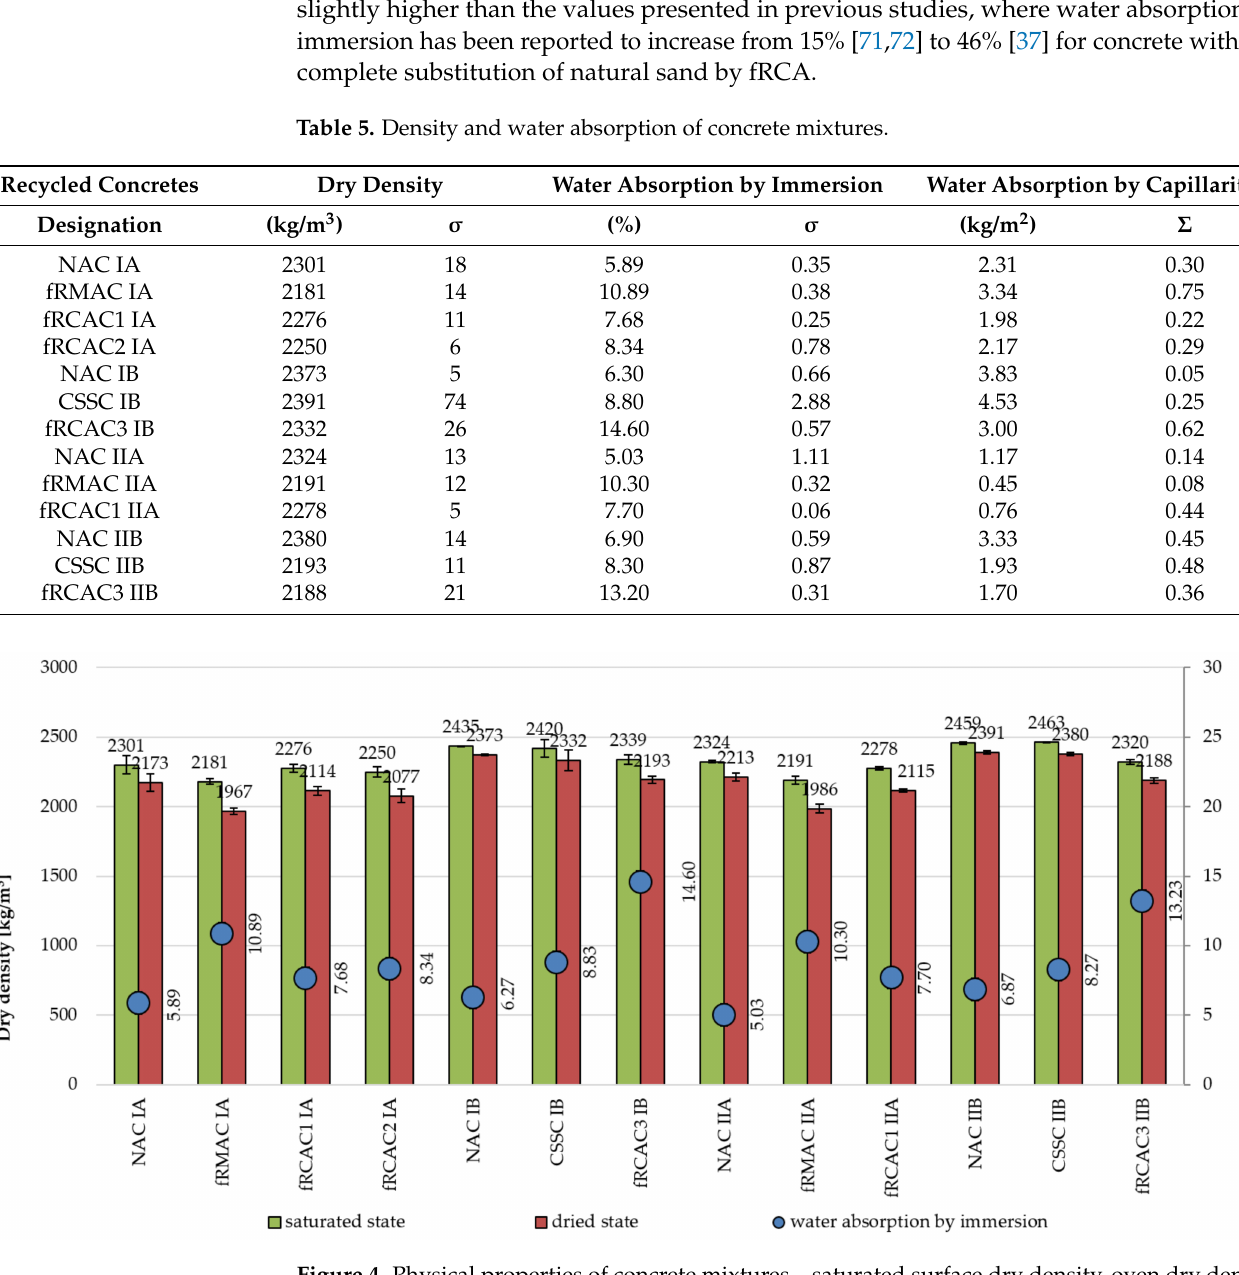
Figure 4. Physical properties of concrete mixtures—saturated surface dry density, oven dry